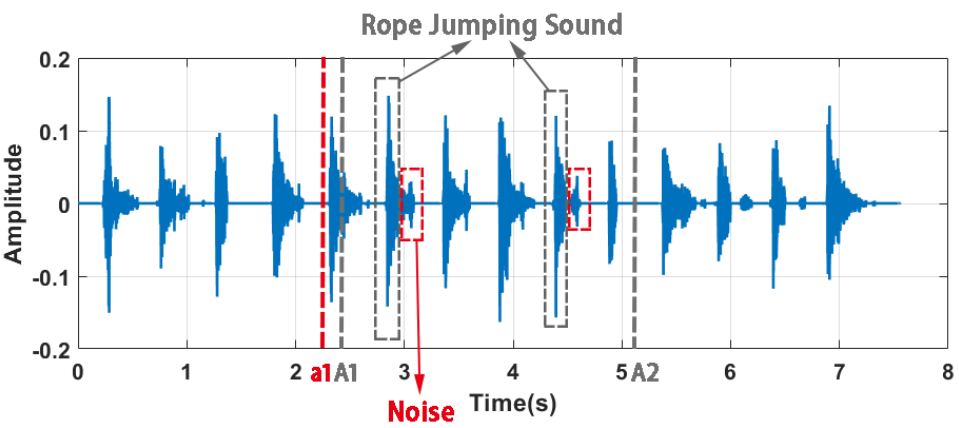
Figure 4. An example of splitting